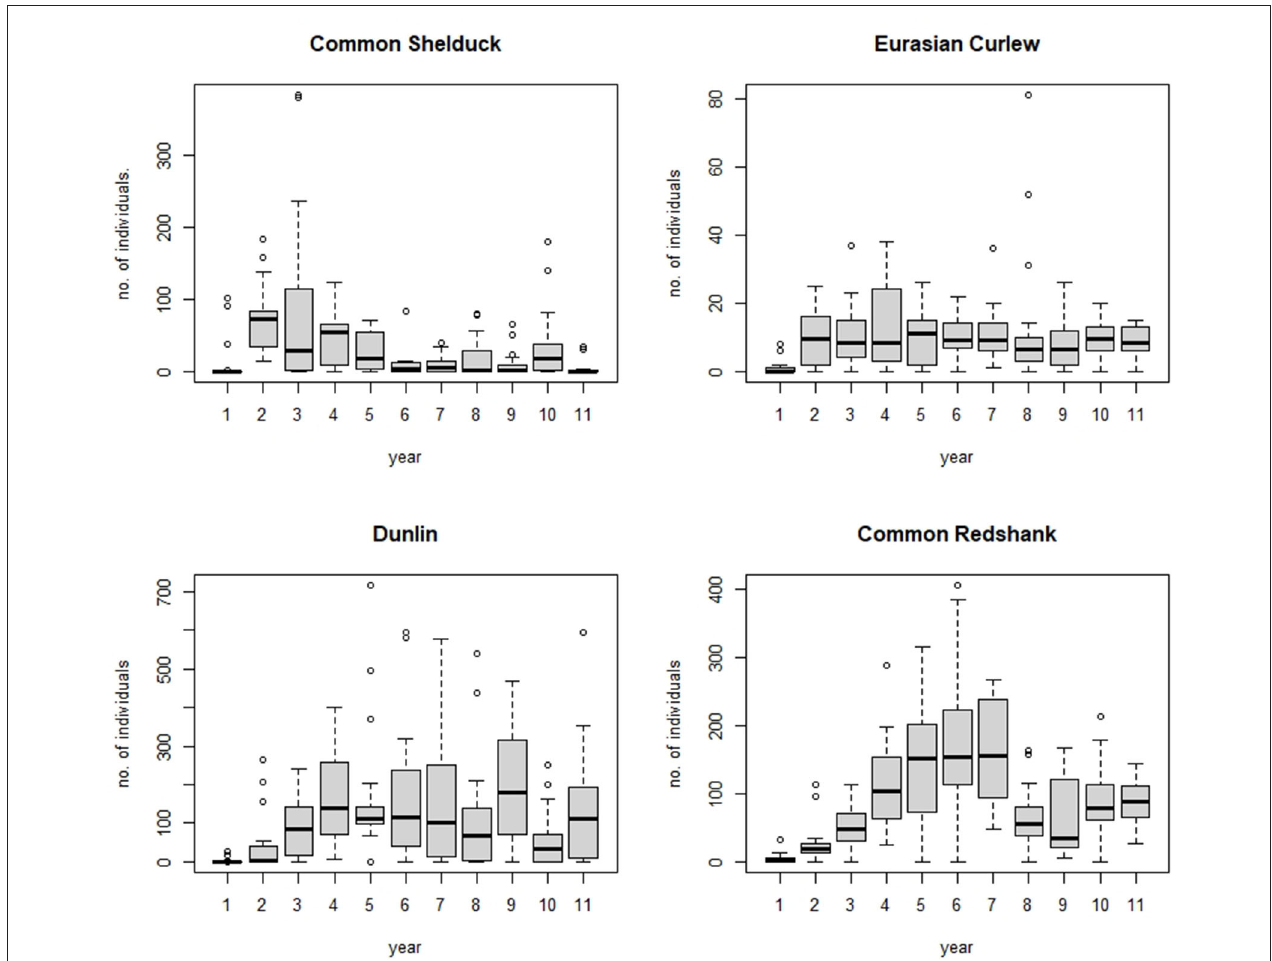
FIGURE 5 | Boxplot of the number of individuals foraging per annum. Box plots represent the median values (horizontal line), interquartile distances (boxes), non-outlier range (whiskers), outliers (circles), and extreme values